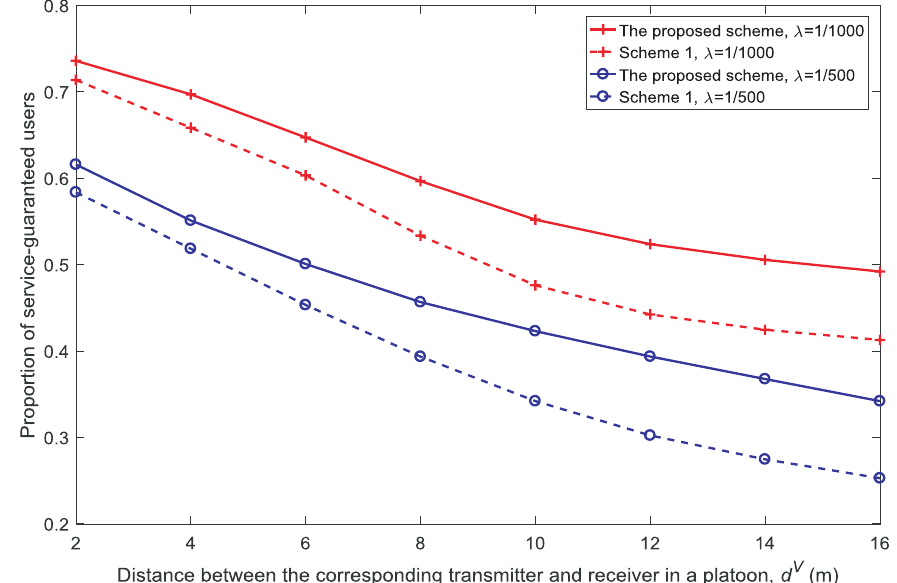
Figure 9. Proportion of service-guaranteed users for different distances between the corresponding transmitter and receiver in a platoon d V ( N = 5, K = 3, V = 10 )